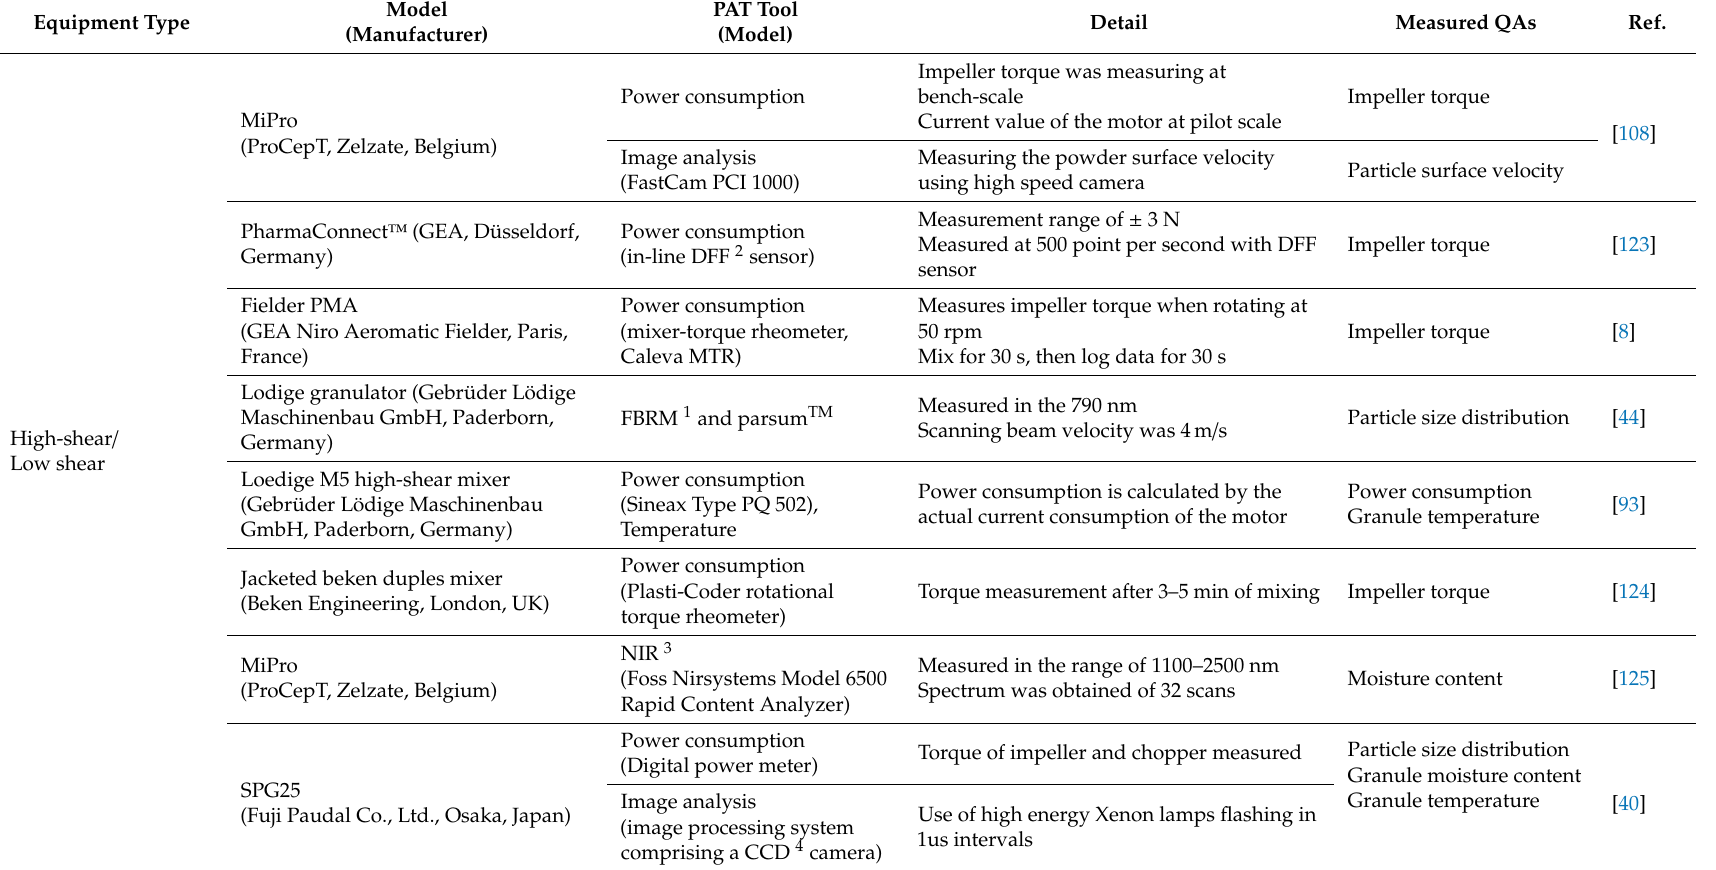
Table 4. Summary of PAT-based modeling method applied in wet granulation